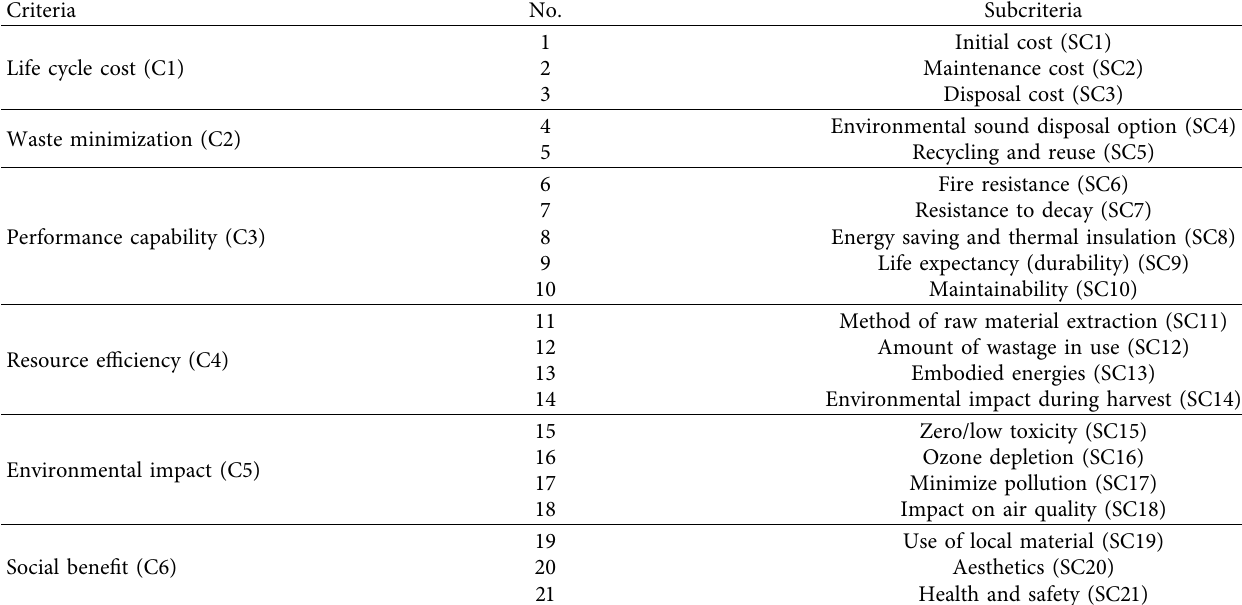
Table 4: Te six most important criteria and subcriteria for the selection of sustainable masonry